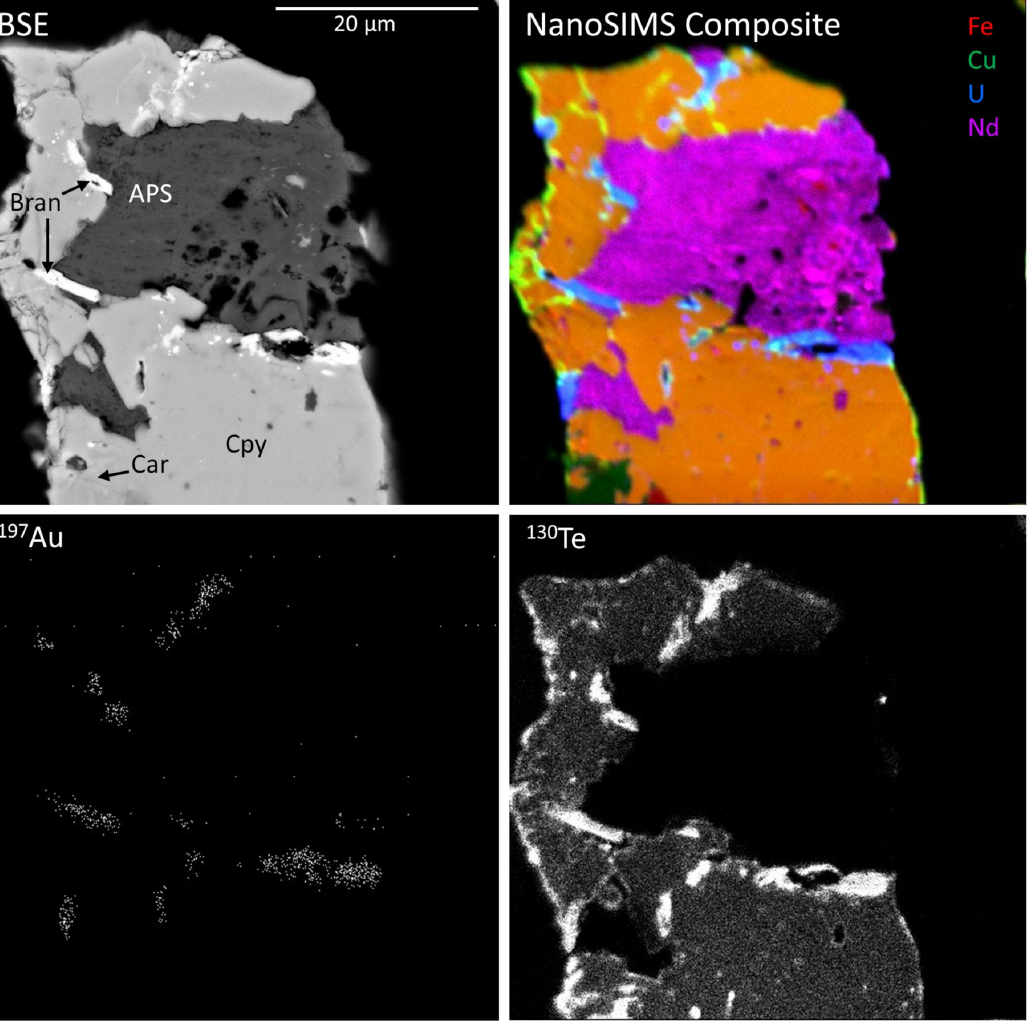
Figure 1. The backscatter secondary electron detector (BSE) image and nanoSIMS images of grain 05CLD27. The composite image contains nanoSIMS overlays of Fe (red), Cu (green), U (blue), and Nd (magenta). Note that orange is the result of a red and green overlap (chalcopyrite in this sample). Abbreviations: (Bran) = brannerite; (Cpy) = chalcopyrite; (Car) = carrollite; (APS) = aluminum phosphate-sulfate phase. Trace levels of Au can be seen coincident with Te, likely as cogenetic nanoparticles in